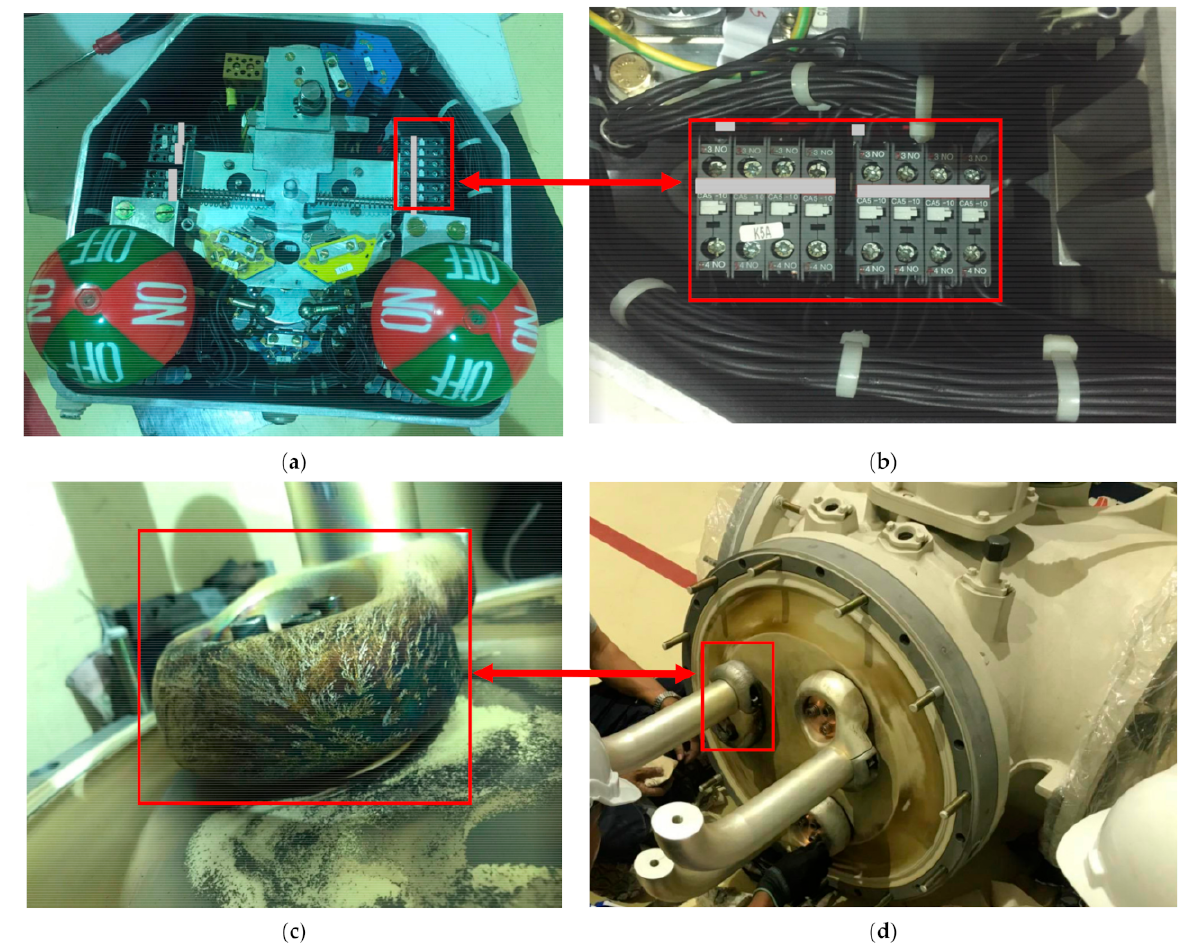
Figure 5. Sample of GIS failure components: ( a ) E02-DS ‘s auxiliary magnetic relay malfunc- tion; ( b ) E02-new auxiliary magnetic relay; ( c ) E05-busbar electrical discharge; ( d ) E05-new busbar